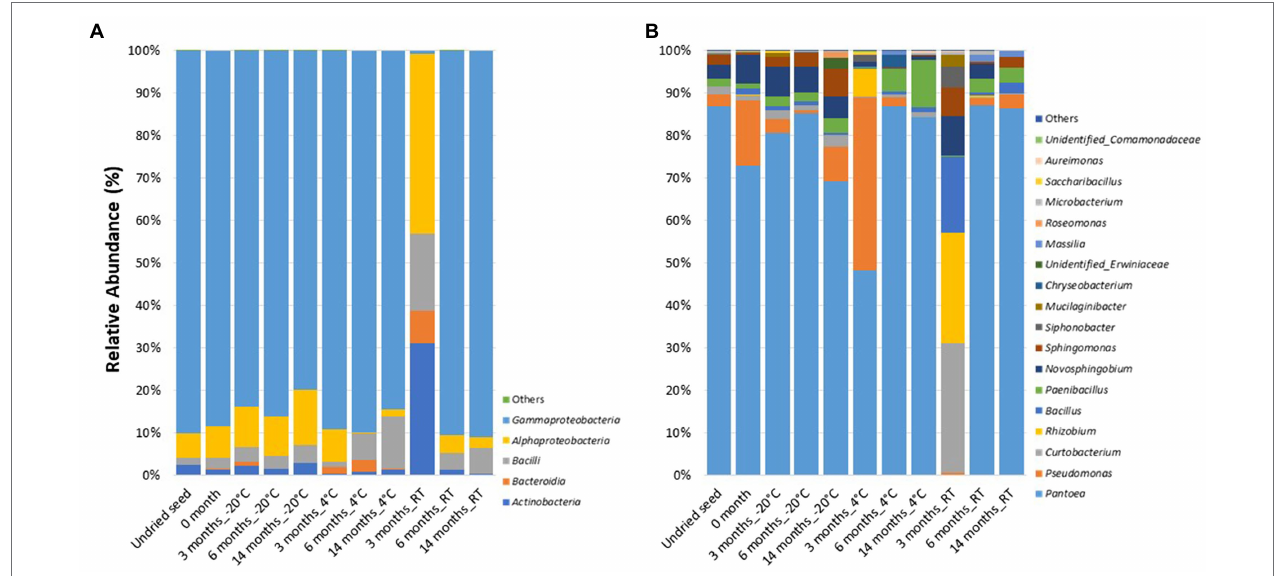
FIGURE 3 | Relative abundance of bacterial taxa on plates (A) at class level and (B) at genus level in undried seed and dried seed stored at different time points (0, 3, 6, and 14 months) at − 20 ° C, 4 ° C, and room temperature (RT). The bacterial taxa occurring with less than 0.1% are shown as